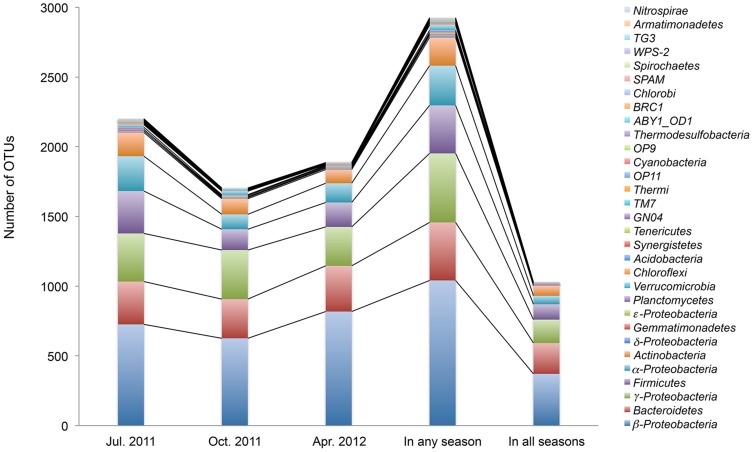
Seasonal composition of aeration-basin bacterial community samples, as represented by the number of OTUs.The composition is shown at the phylum level, or at the class level for the phylum Proteobacteria. An OTU was counted present if it was detected in at least two of three sample replicates.